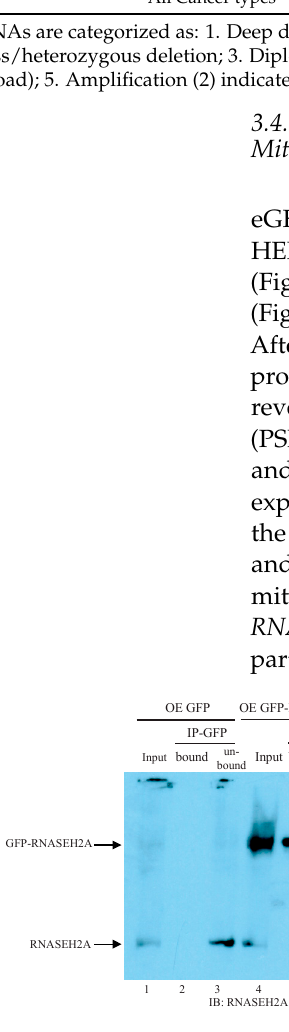
3.5. RNASEH2A Expression Positively Correlates with Cancer Proliferation Markers and Cell Cycle Genes To further explore the involvement of RNASEH2A in cancer, we examined the corre- lations between RNASEH2A and 39 additional genes in CCLE and TGCA Pan Cancer da- tasets (Table 5 and Table S14a,b). The correlation analysis uncovered a positive correlation of RNASEH2A with genes up-regulated in cancer and a negative correlation with genes that are instead down-regulated. In addition, RNASEH2A showed a higher correlation with cluster of genes known to play a role in cancer proliferation as compared to RNASEH2B, RNASE2C, and RNASEH1. We also observed a similar trend for the three putative binding partners of RNASEH2A that we identified by mass spectrometry, show- ing a correlation comparable with that found in the GTEx dataset. The analysis of cell cycle related genes showed a high correlation between RNASEH2A and genes involved in Gap 1/Synthesis (G1/S), Gap 2 (G2), G2/Mitosis (M), M, and M/G1 phases and a comparatively lower or no correlation with genes unique to G1 and S phases (Figure 5 and raw data in Figure S15a,b).